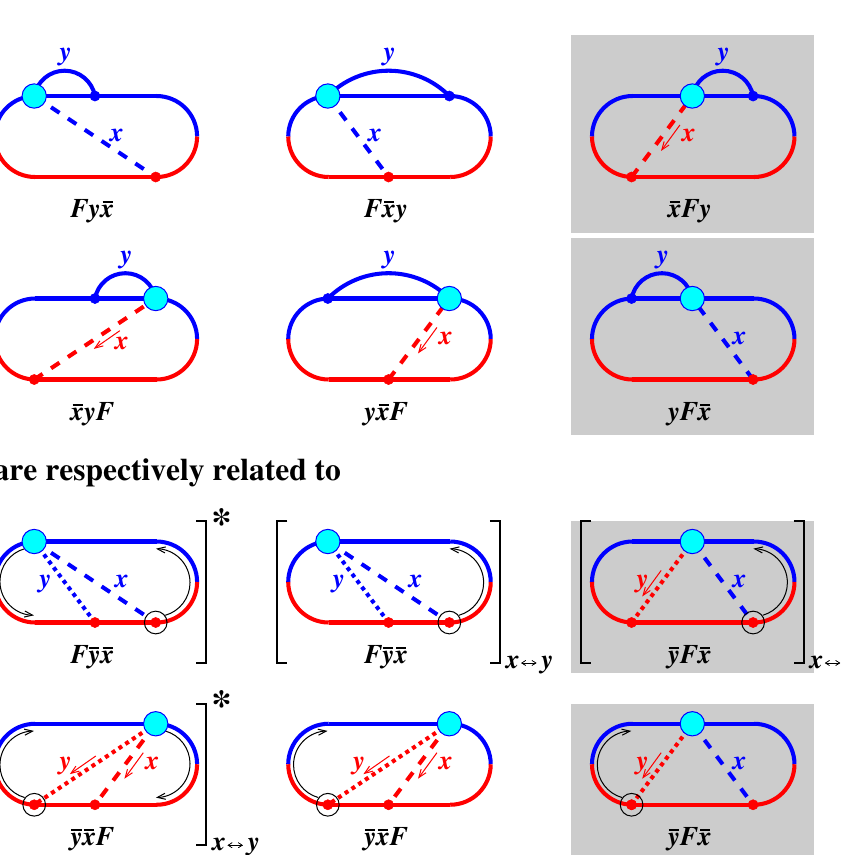
Figure 15 . Relation of the virtual diagrams of figures 5 and 6 to the real g → ggg diagrams of figure 4 by various combinations of front- and back-end transformations, complex conjugation, and swapping variable names x ↔ y . Complex conjugation corresponds to flipping a diagram upside down and swapping the colors blue (amplitude) and red (conjugate amplitude). Complex conjugation is irrelevant, however, because ultimately we want to take 2 Re( · · · ) of all the virtual diagrams, i.e. add them to their complex conjugates. Shading above indicates diagrams that happen to be exactly zero, because the ¯ yF ¯ x diagram vanishes for the reason described in section